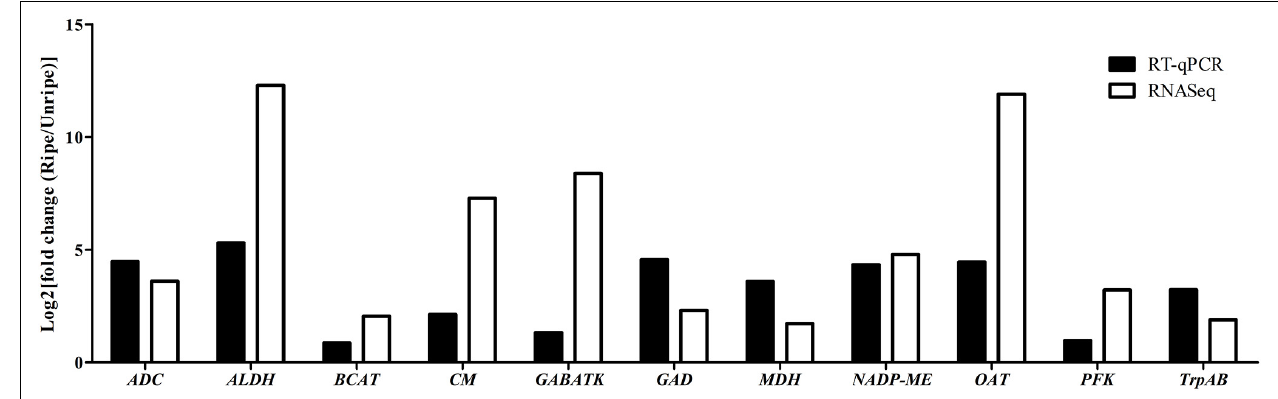
FIGURE 4 | Log 2 fold change in expression values in the ripe pulps relative to unripe pulps, as measured with RNA-seq and RT-qPCR in the 11 selected